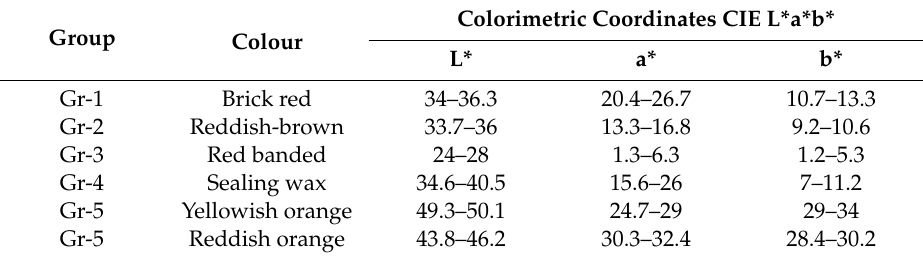
Figure 10. CIE Lab graphic representation: L* a* b* chromatic coordinates of the samples projected on the L* a* b* space. Table 2. Average chromatic and colourimetric coordinates of the five groups.